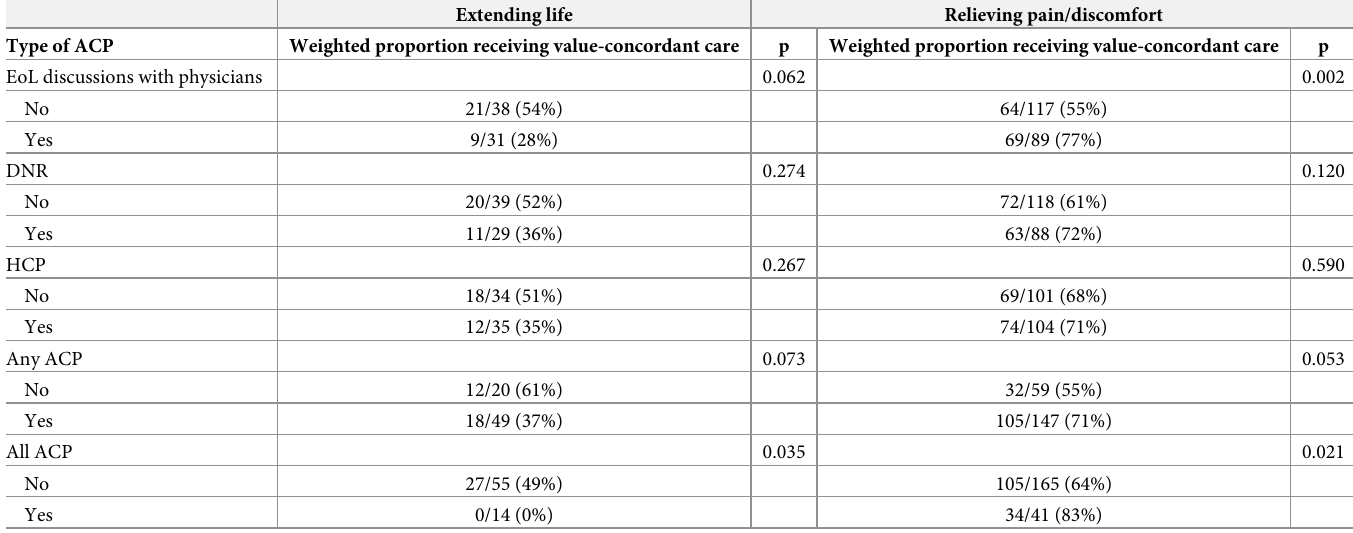
Table 5. Weighted proportion of patients receiving value-concordant care by treatment preference and type of advance care planning, using hospice for at least one week as sole indicator of value-concordant care (N = 275). Extending